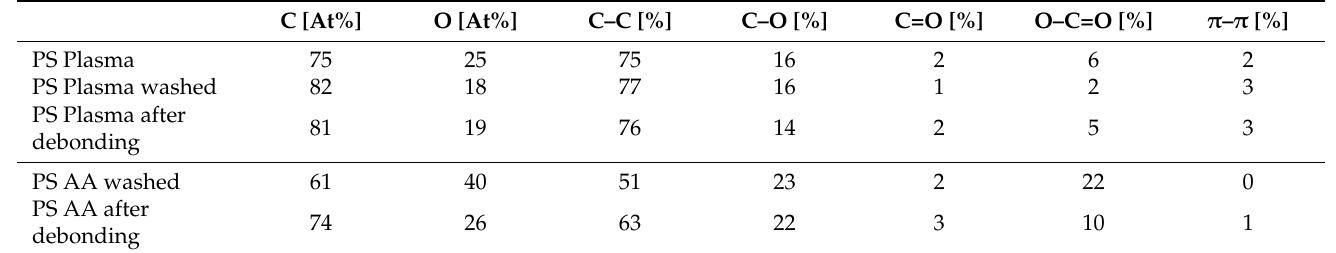
Table 2. XPS measurement. Atomic composition and functional groups of surface-treated polystyrene before and after washing and after